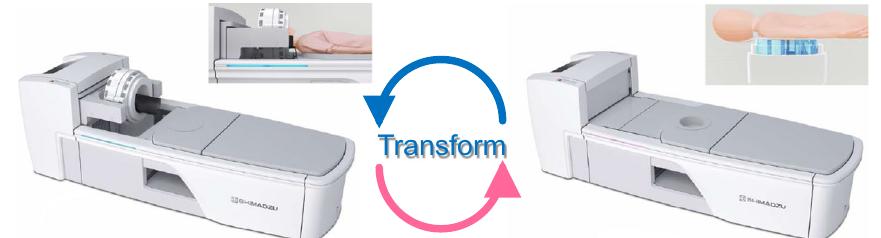
Fig. 1 Dedicated brain and breast PET system designed to switch between head scan and breast mode